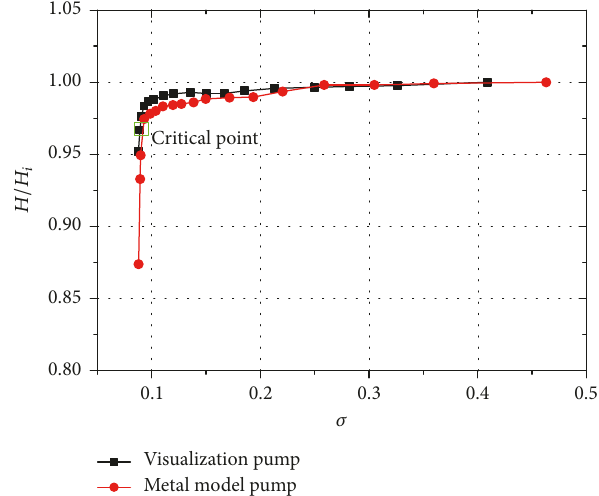
Figure 5: Comparison of cavitation curves between the metal and visualization model pumps.